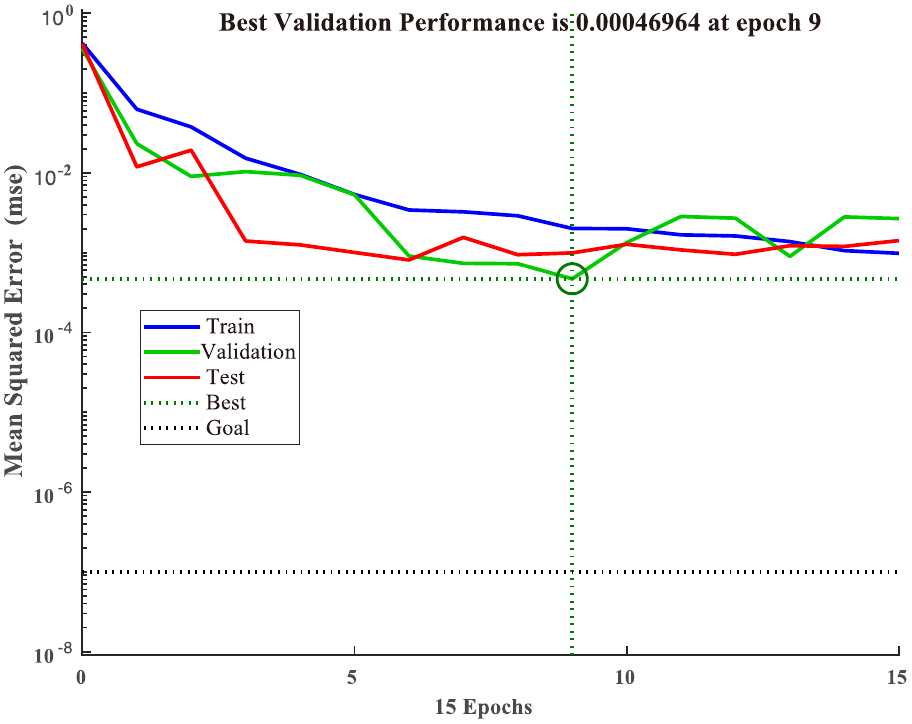
Figure 8. Performance of the developed ANN model.